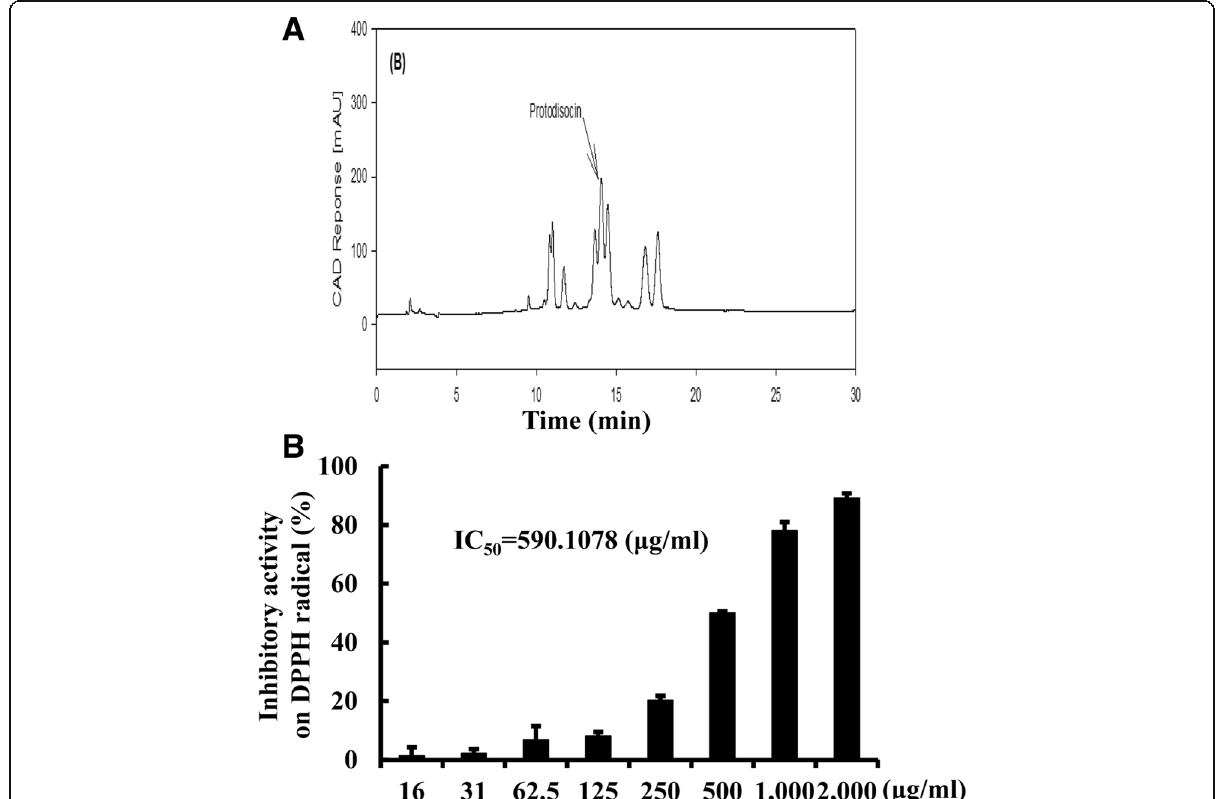
Fig. 1 Biochemical properties of AEAC. a Chromatograms of the protodioscine were obtained by high performance liquid chromatography of AEAC. The peak height/area reflect the concentration of the protodioscine in AEAC. b Free radical scavenging activity of AEAC. DPPH radical scavenging activity was assayed in a mixture containing 0.1 mM DPPH and a range of concentrations of AEAC (16 – 2,000 μ g/ml). DPPH, 2,2-diphenyl-1-picrylhydrazyl radical; IC 50 , half maximum inhibitory concentration. Values are presented as the means ± SD of three